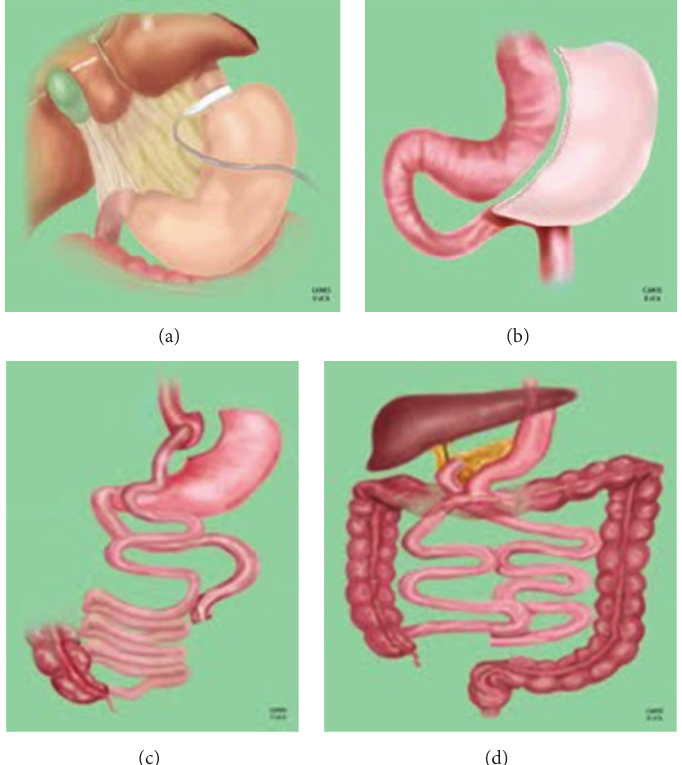
Figure 1: Most commonly performed bariatric surgical procedures. (a) Laparoscopic adjustable gastric banding; (b) sleeve gastrectomy; (c) Roux-en-Y gastric bypass surgery; (d) biliopancreatic diversion with duodenal switch. Reproduced with permission from the Centre for the Advancement of Minimally Invasive Surgery (CAMIS), University of